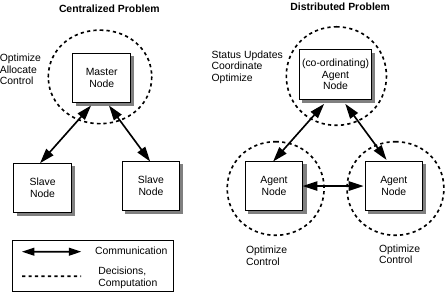
Figure 3. Centralized vs. Distributed